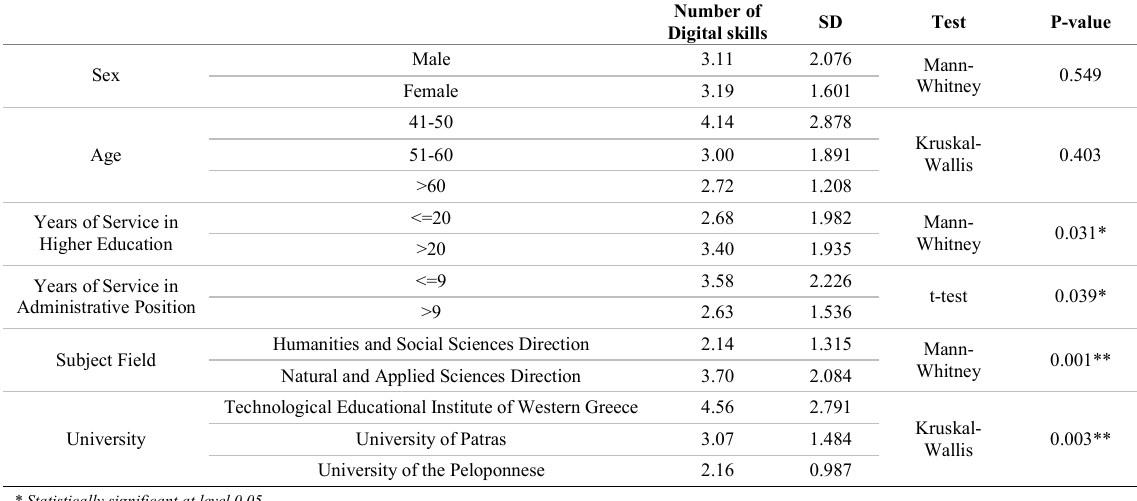
Table 21. Number of digital skills per demographic feature.